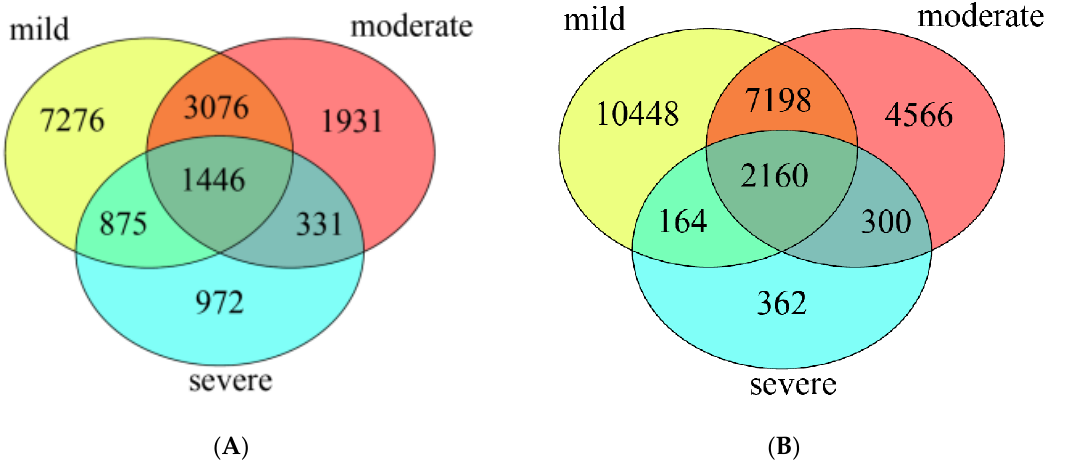
Figure 2. The unique and overlapped OTUs detected in water samples ( A ), and in sediment samples ( B ).